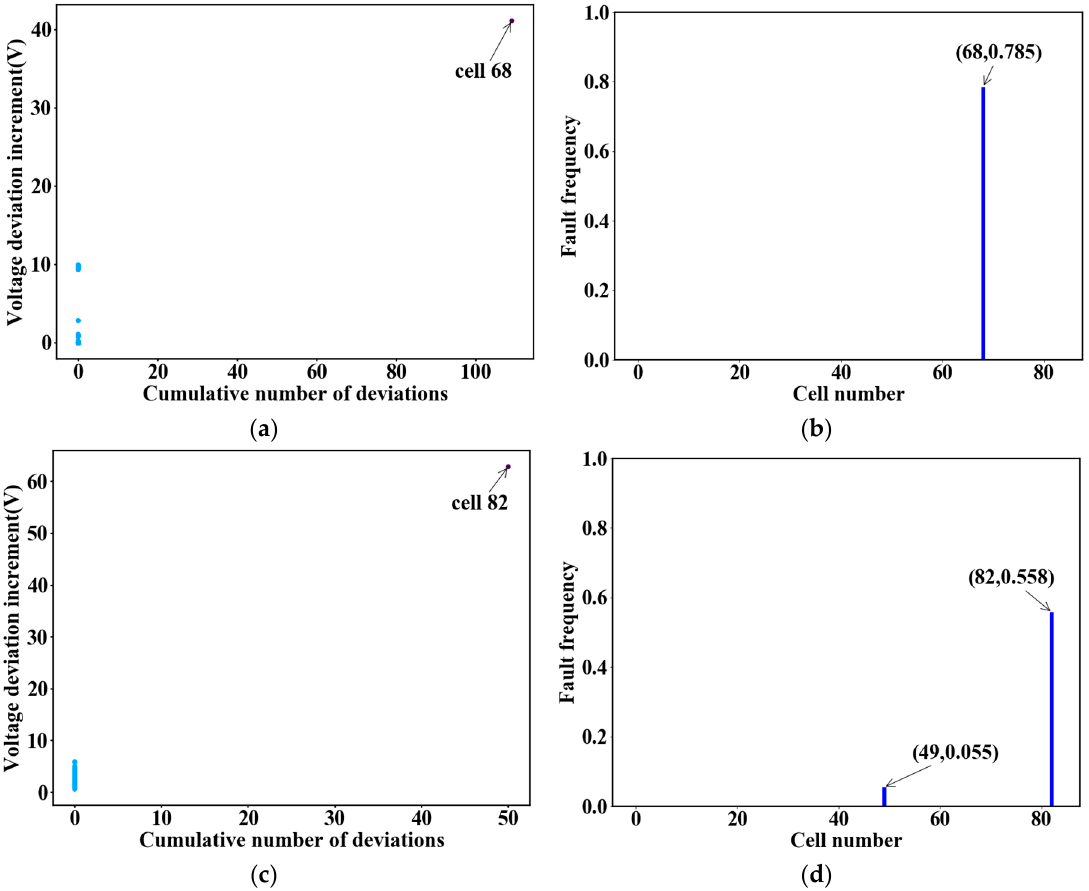
Figure 11. ( a ) Clustering result of vehicle 3; ( b ) Fault frequencies of battery cells in vehicle 3; ( c ) Clustering result of vehicle 4; ( d ) Fault frequencies of battery cells in vehicle 4.